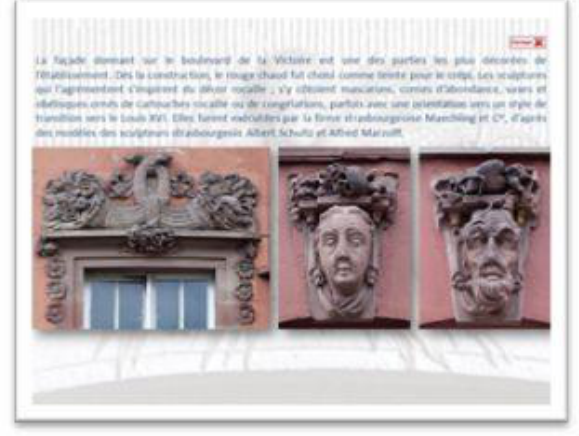
Figure 8: Complementary information sheet.